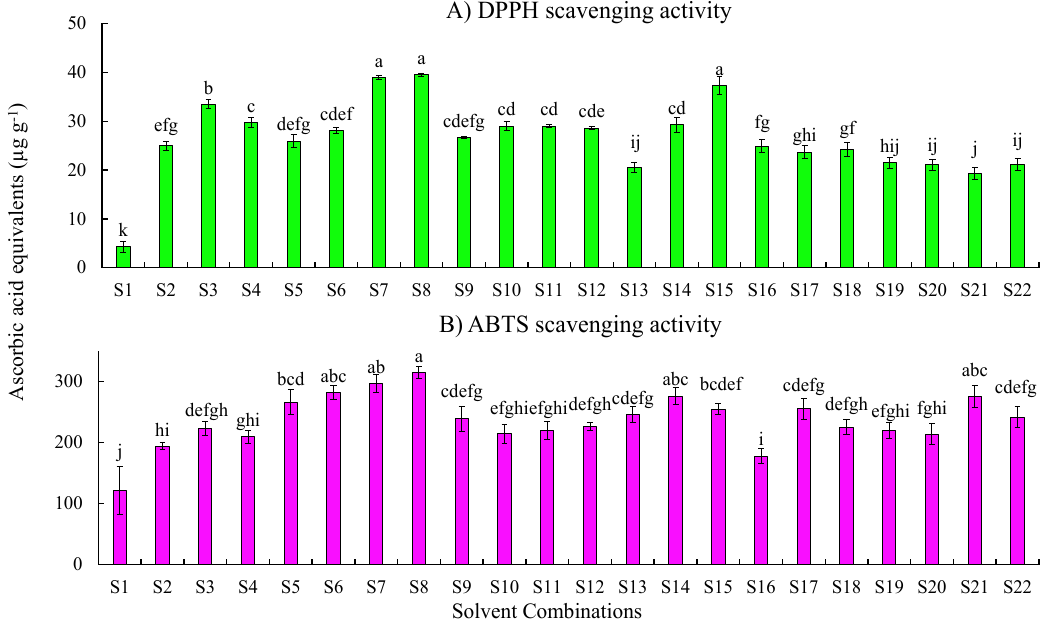
Figure 1. Free radical scavenging activity of cantaloupe extracts measured by the ( A ) DPPH assay and ( B ) ABTS assay.